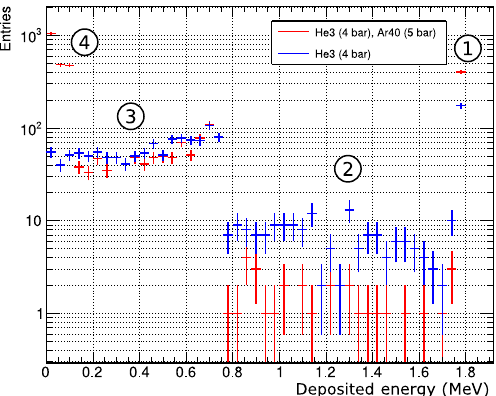
at 400 kPa (blue) and the gas mixture corresponding to our detector gas composition made of 400 kPa of 3 He + 500 kPa of 40 Ar